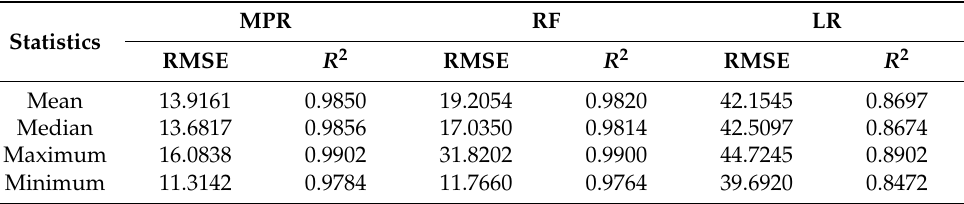
Figure 3. Results from the 5-fold cross-validation training dataset to evaluate the performance of MPR, RF, and LR: boxplots for ( a ) R 2 and ( b ) RMSE. Table 2. Cross-validation measurement results.